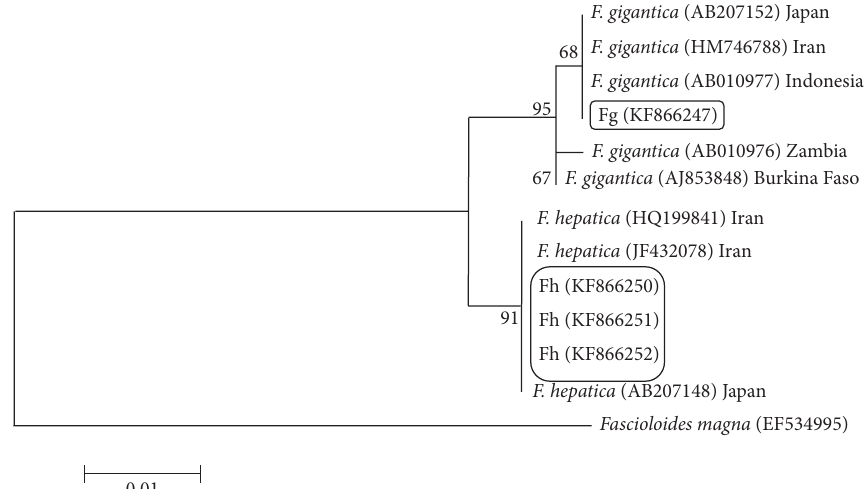
Figure 6: Phylogenetic relationship of ITS2 sequences of isolates of Fasciola hepatica and Fasciola gigantica from Iran using Maximum Likelihood method. Fascioloides magna (AN: EF534995) was used as the out